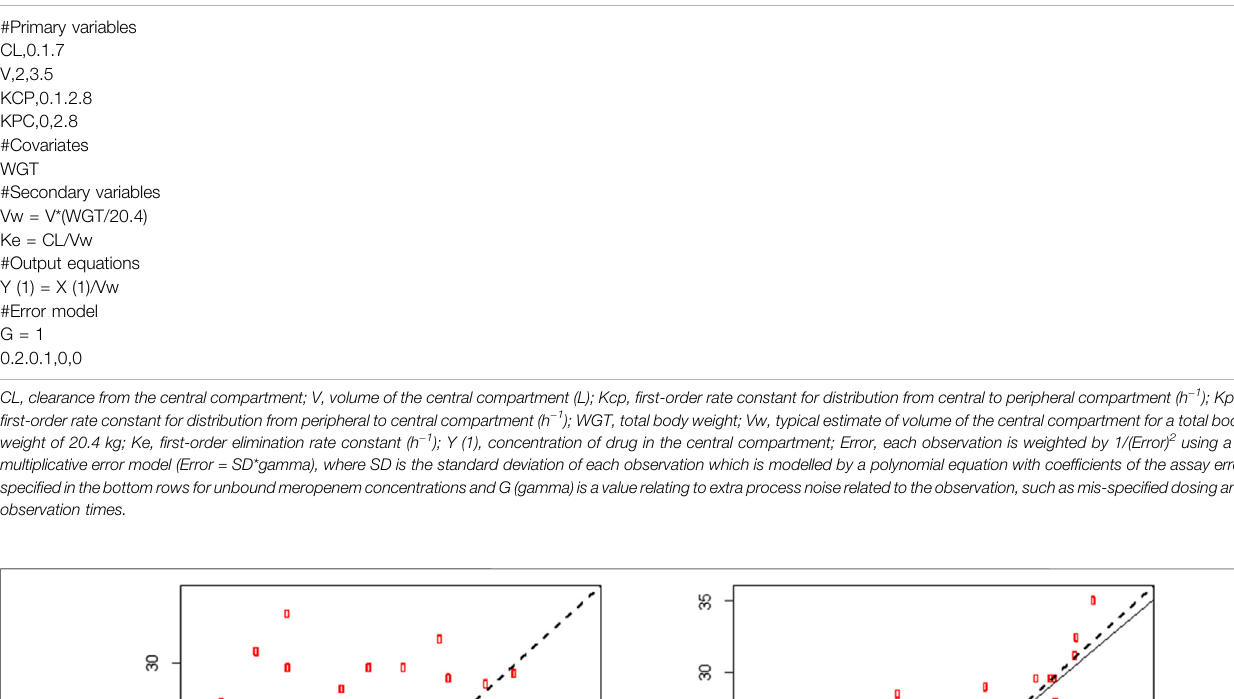
Frontiers in Pharmacology |